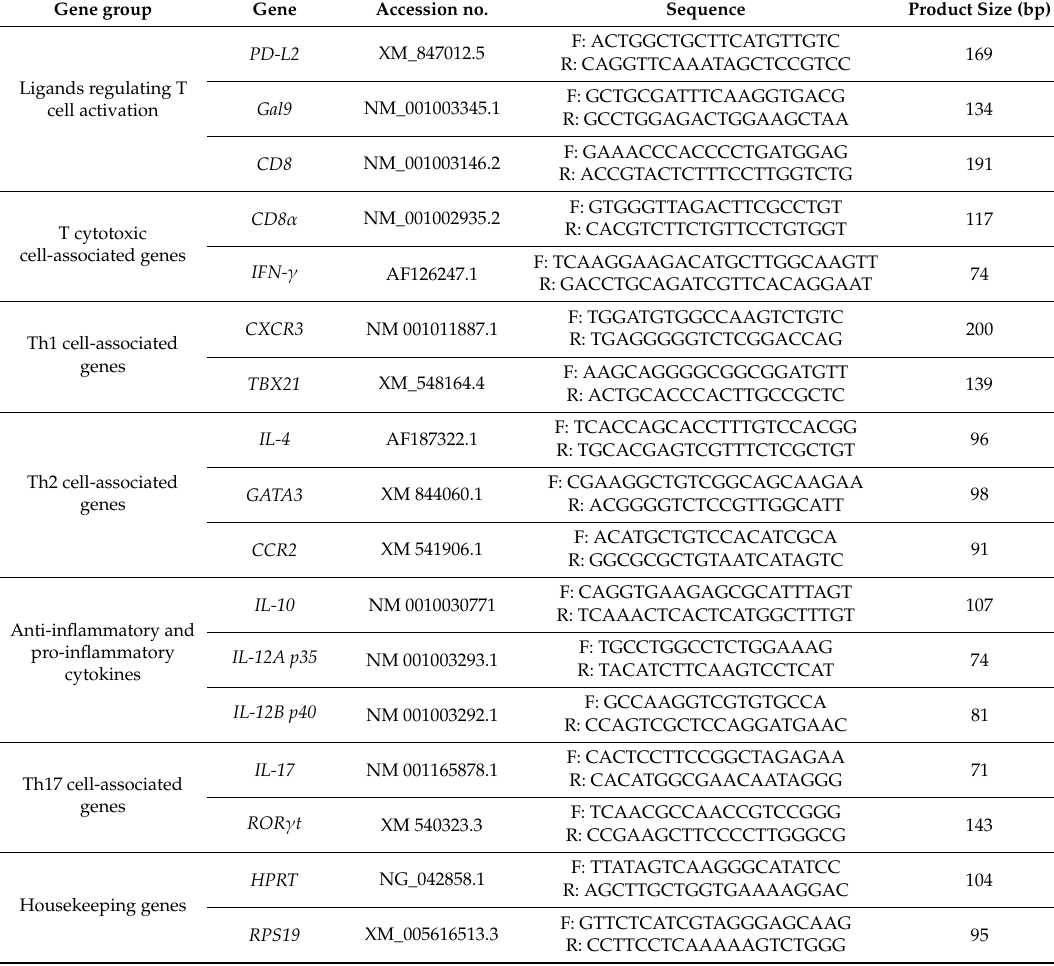
Table 1. Sequences of primers used for